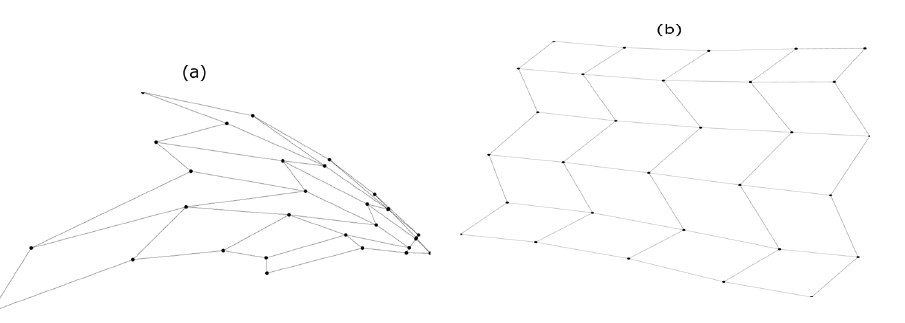
Figure 2. Sammon map projection of ERA5 hourly SLP during fine–tuning: ( a ) after 10,000 iteration steps, and ( b ) after 131,496 iteration